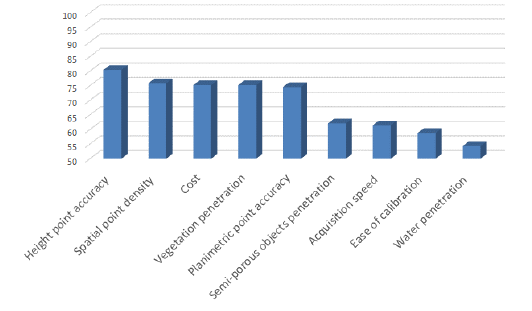
Figure 3. Important characteristics of SP/GM lidar.